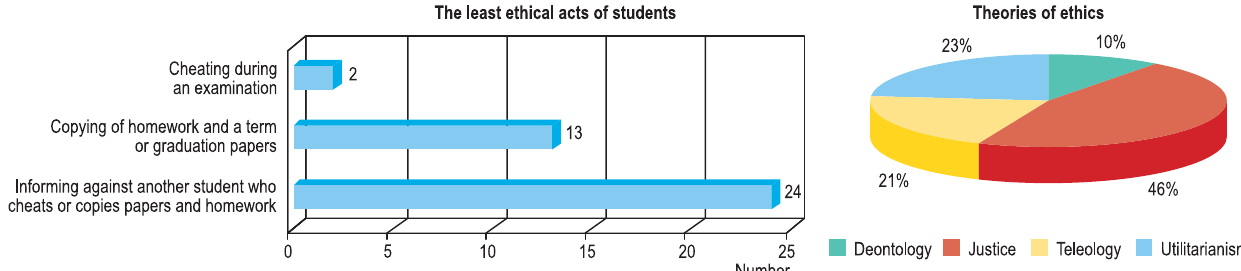
Fig. 3 . The leas t ethical acts of students ( on the left ) and theories of ethics selected by the students ( on the right )